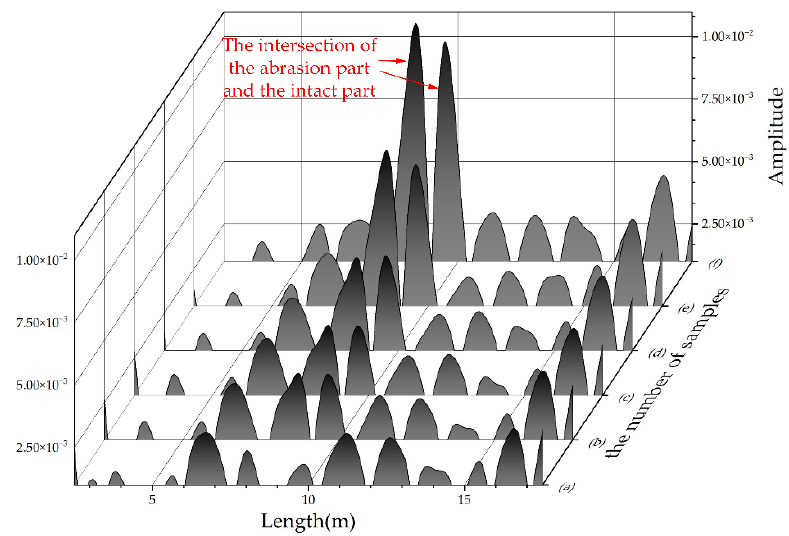
Figure 9. The location spectra of the cable samples with abrasion.